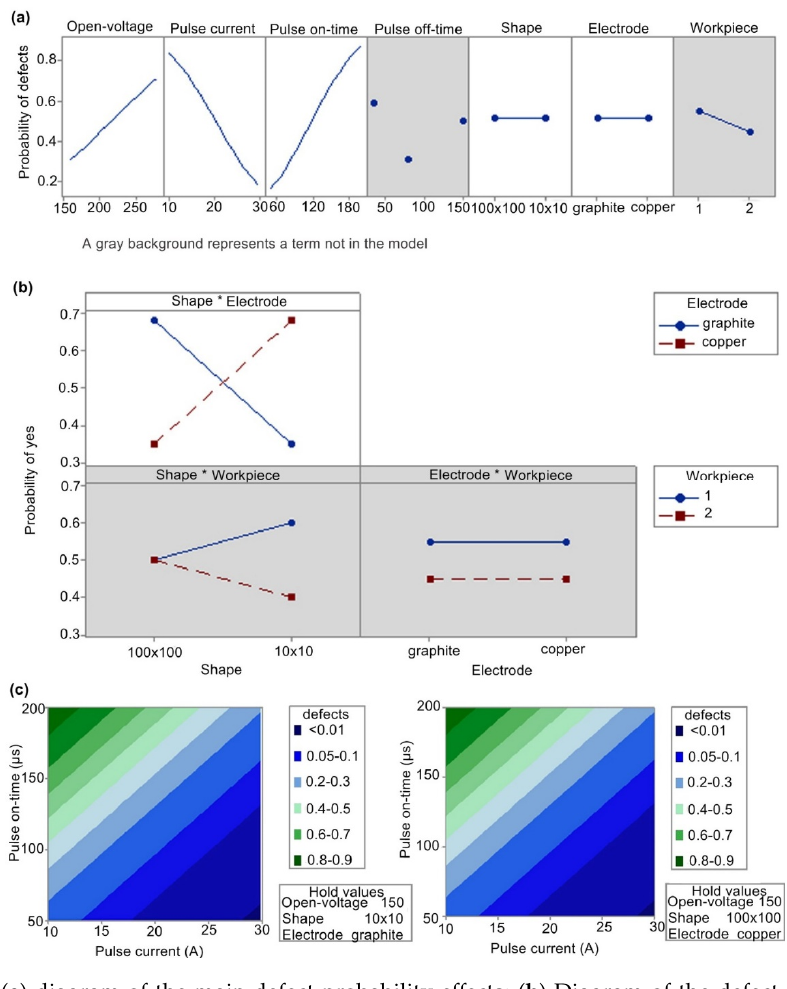
Figure 5. ( a ) diagram of the main defect probability effects; ( b ) Diagram of the defect probability interactions; ( c ) Contour probability contour plots. Coatings 2020 , 10 , 406